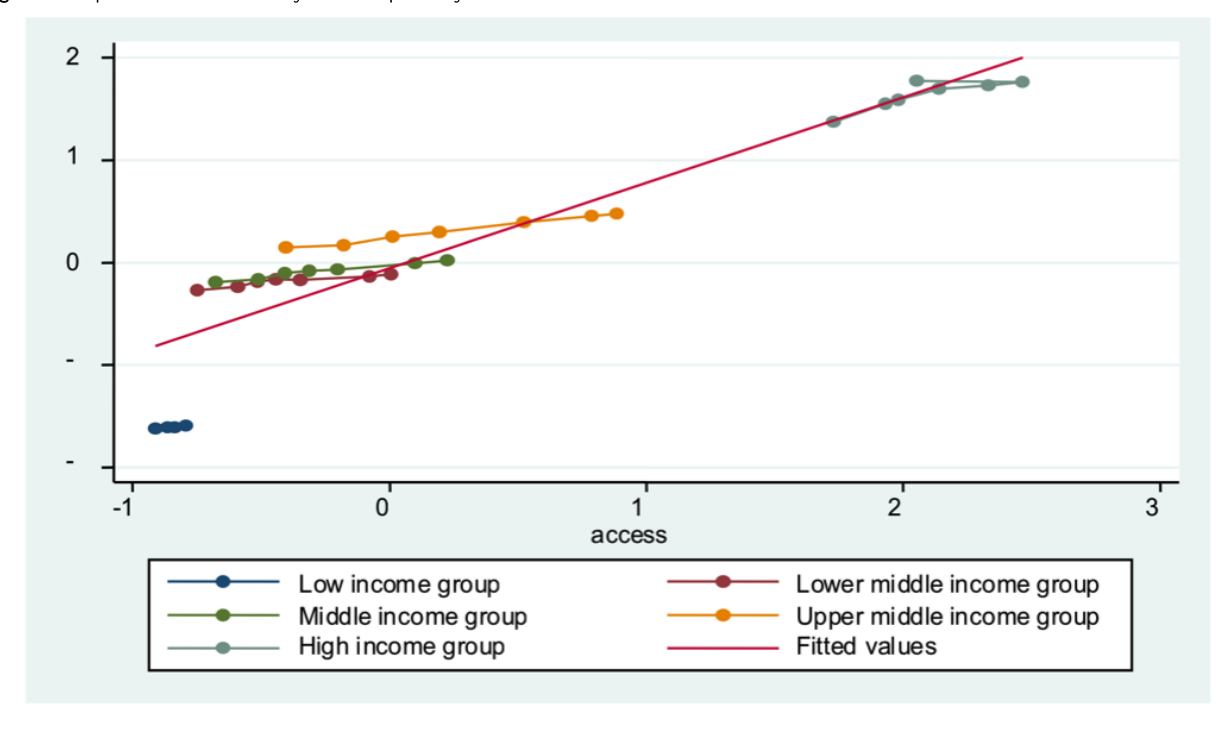
Figure 6. Impact of ICT accessibility on life